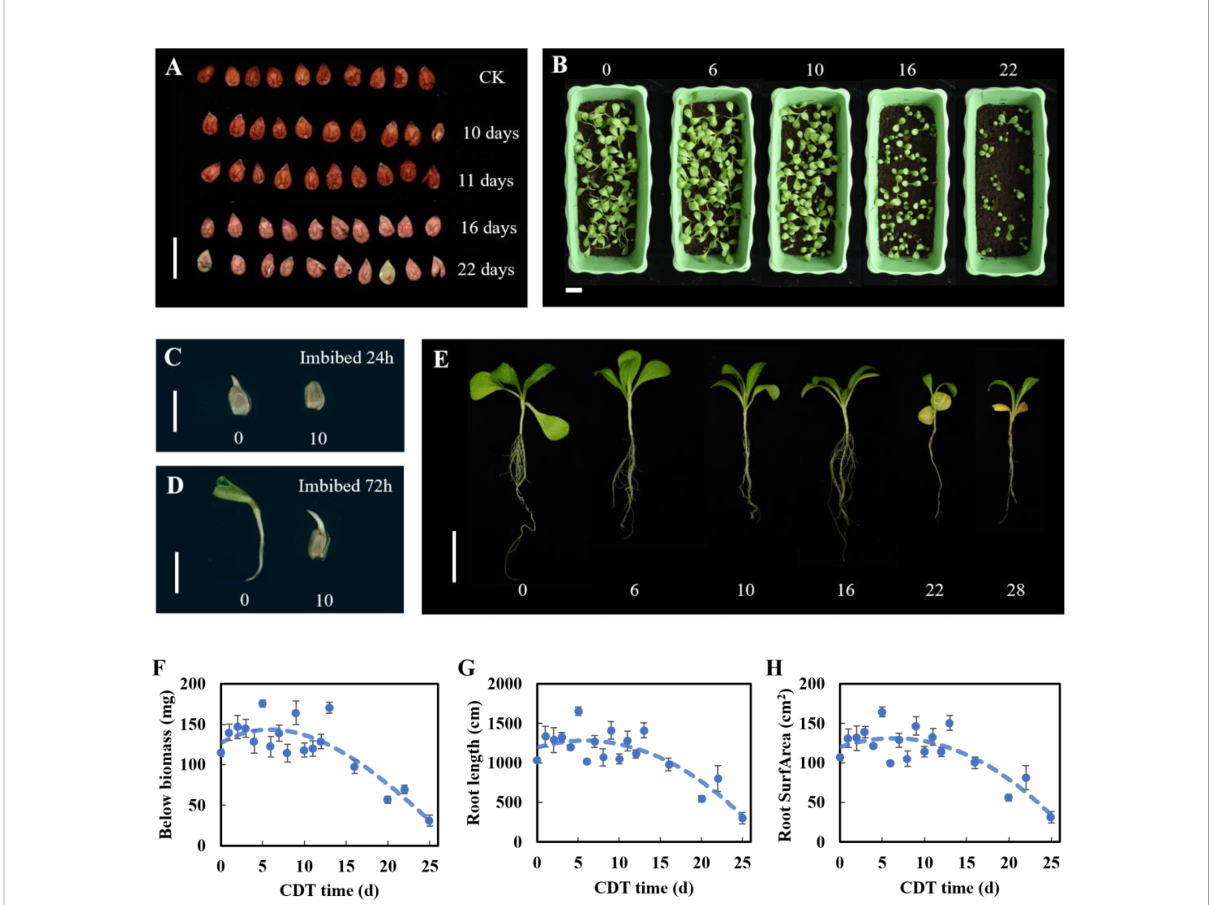
FIGURE 6 Effect of aging on seed vigor and seedling establishment. (A) Seed vigor. Scale bar = 10 mm. (B) Seedling phenotype (15 days after sowing). Scale bar = 50 mm. (C, D) The growth of C0 and C10 seeds after 24 and 72 h of imbibition. Scale bar = 10 mm. (E) Growth of seedlings with different aging times. Scale bar = 50 mm. (F – H) Root biomass, root length, and root surface area of